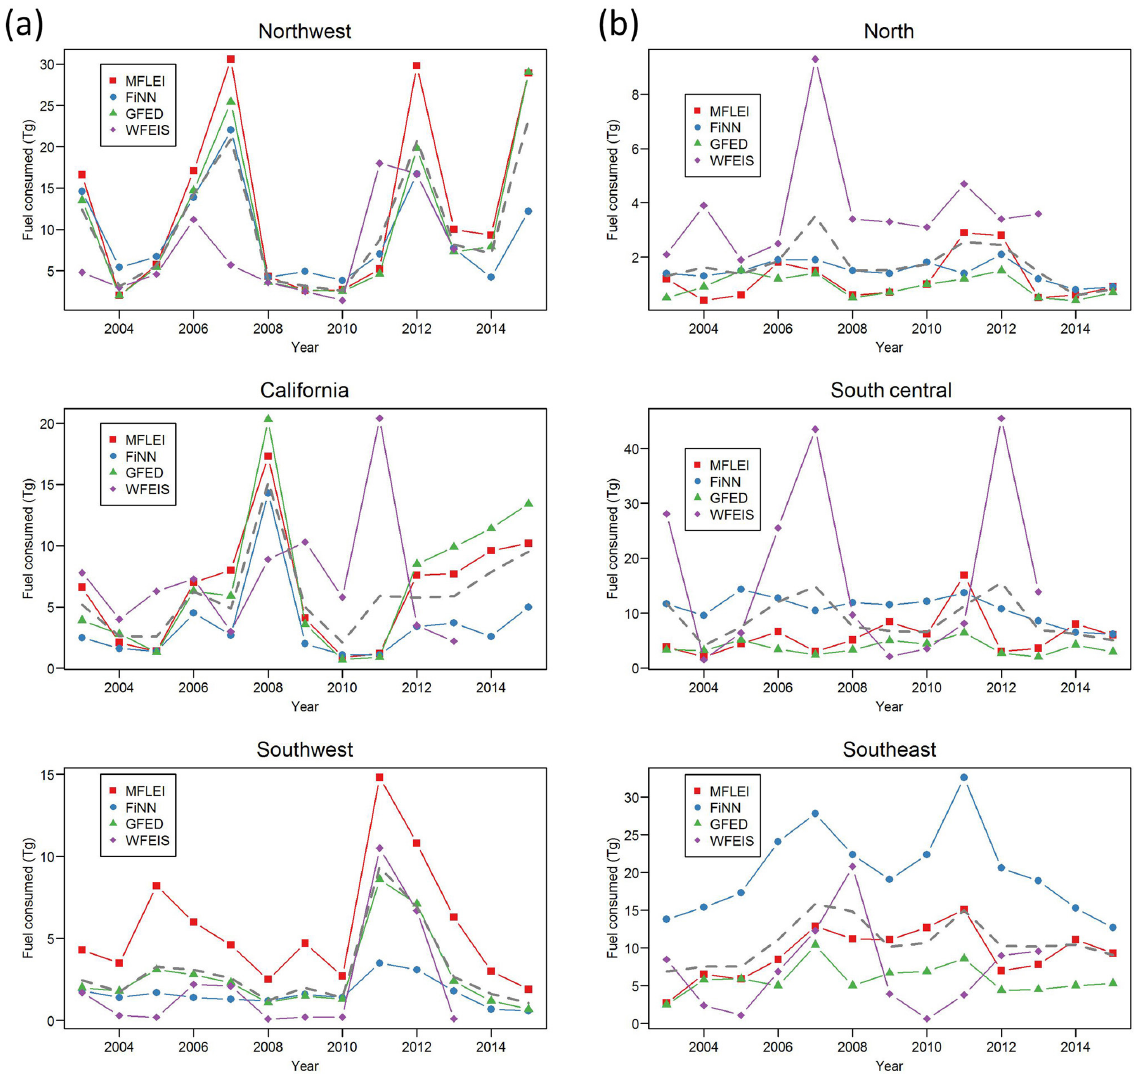
Figure 22. Annual fuel consumption from MFLEI, FINN v1.5, GFED v4.1s, and WFEIS v0.5 for (a) northwest, California, and southwest regions and (b) north, south-central, and southeast